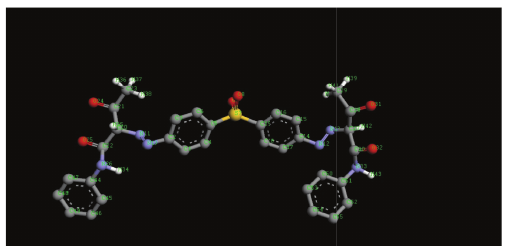
Figure 2: Optimised geometry of ligand (L 󸀠 H 2 ).